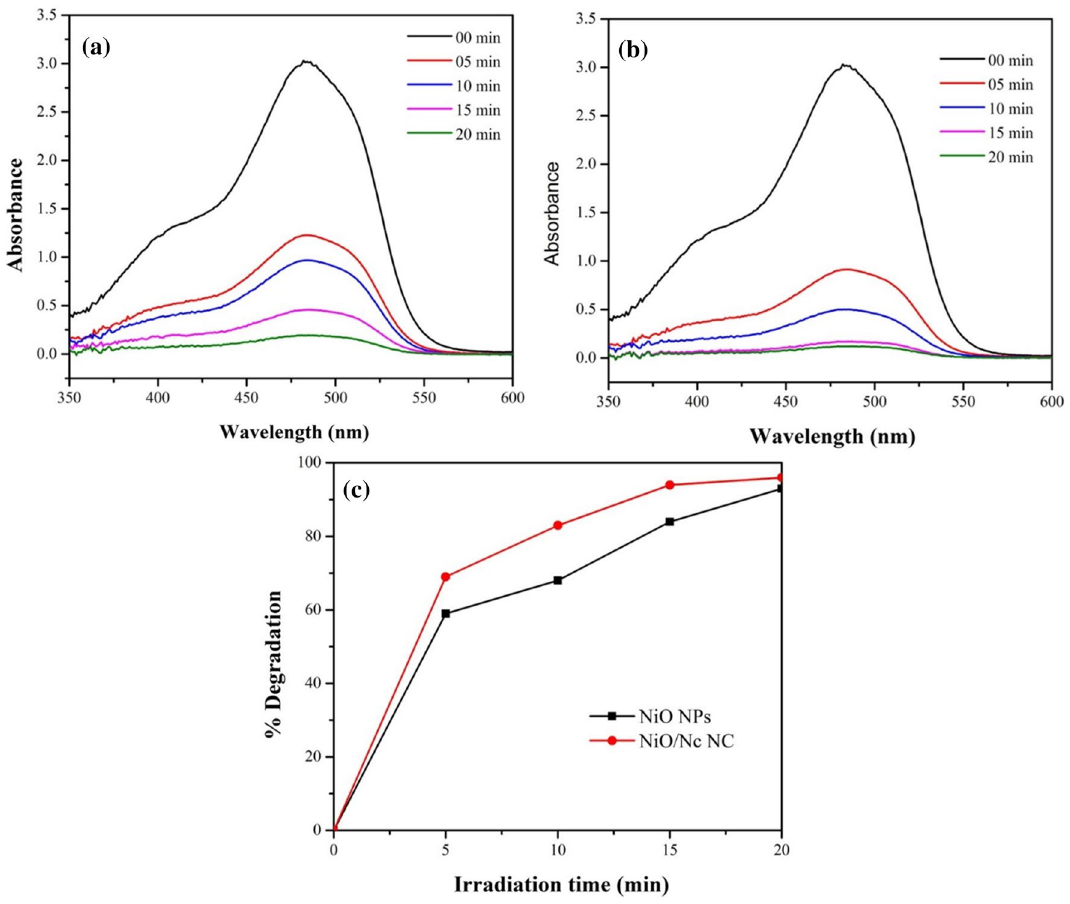
Fig. 5 a UV/ VIS spectra of O II dye photodegraded by NiO NPs b UV/VIS spectra of OII dye photodegraded by NiO/Nc NC c % degradation of O II dye